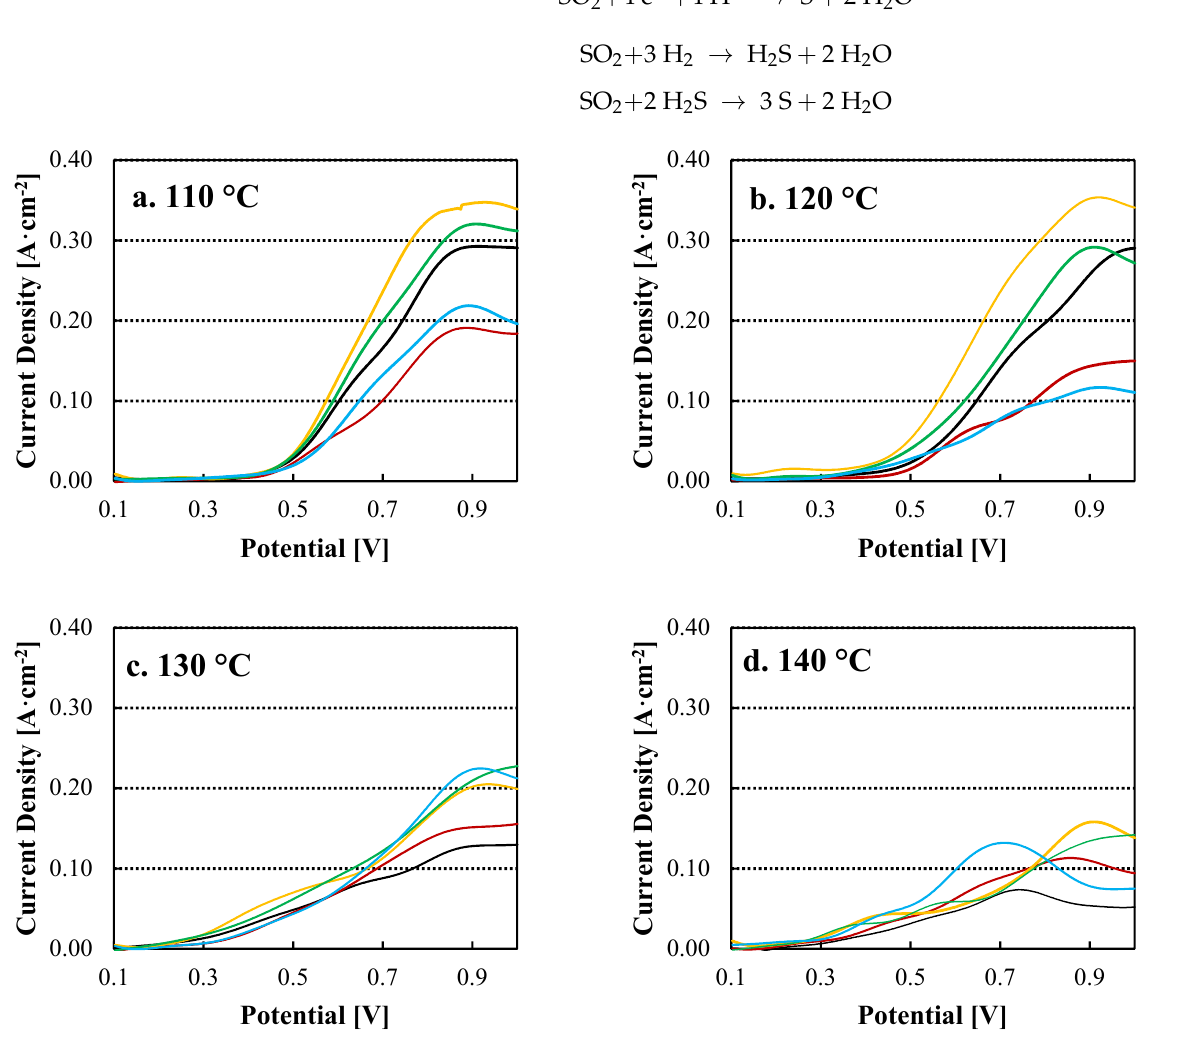
Figure 4. Linear sweep voltammetries for the pristine and composite membranes at different temper- atures. Black line: Std-PBI; Red line: 0.5 wt% TiO 2 -PBI; Yellow line: 1.0 wt% TiO 2 -PBI; Green line: 2.0 wt% TiO 2 -PBI; Blue line: 3.0 wt% TiO 2 -PBI . ( a ) 110 °C; ( b ) 120 °C; ( c ) 130 °C; ( d ) 140 °C.